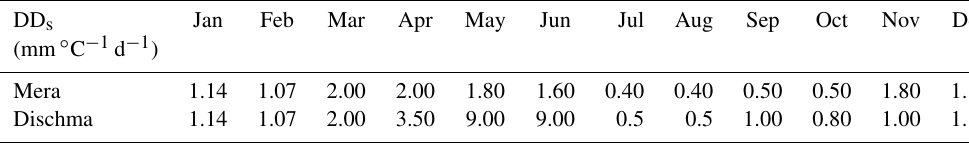
Table 7. Snow degree days used by the Poli-Hydro model for the Mera and Dischma catchments.